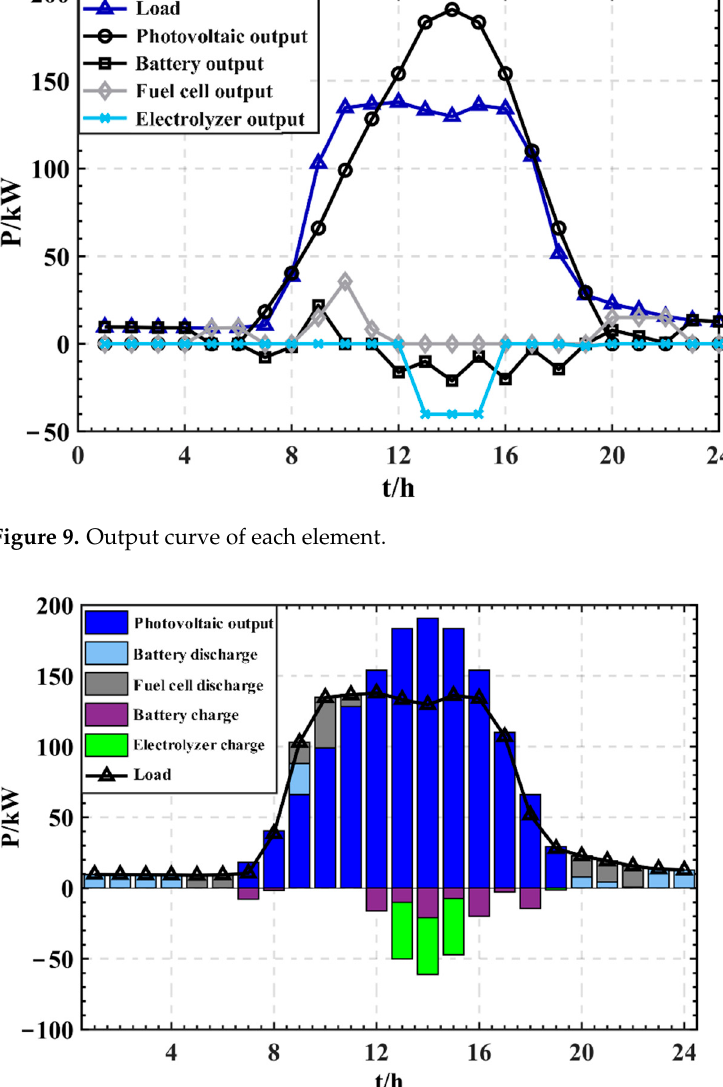
Figure 10. Power balance of the system.